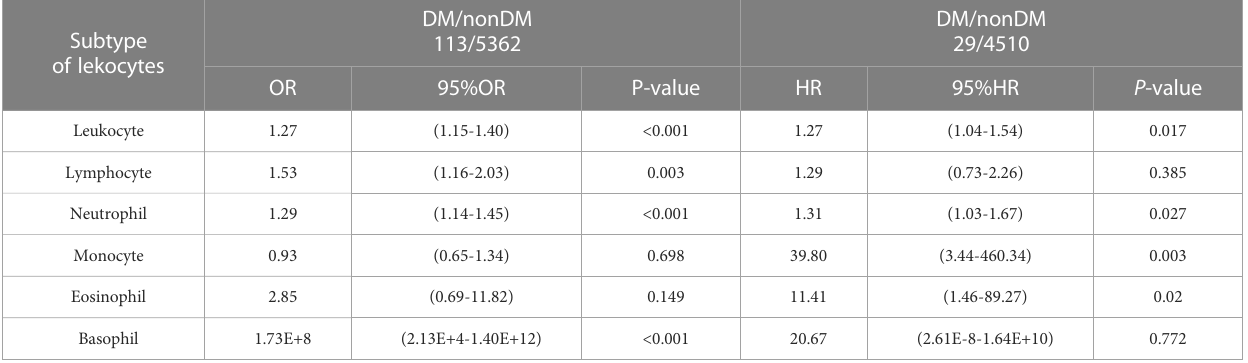
TABLE 3 Univariate regression